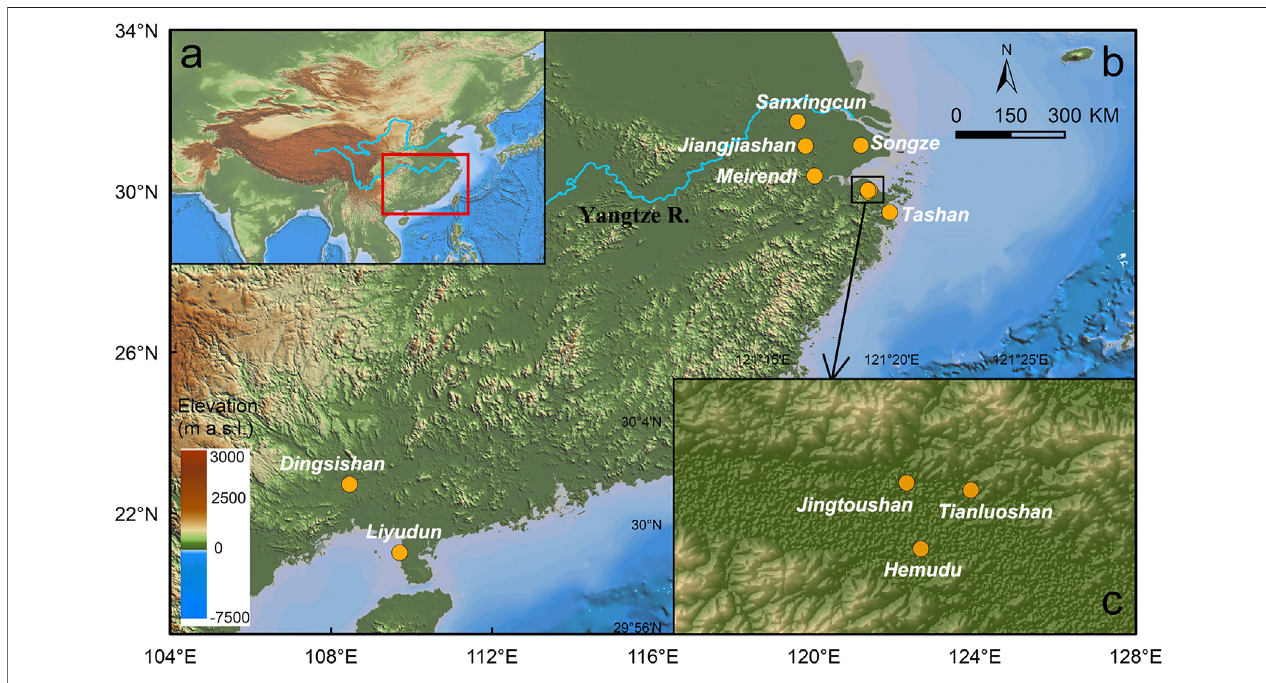
FIGURE 1 | The geographic location of archaeological sites edited by Bing Yi. (A) The study area; (B) Locations of archaeological sites mentioned in the text. (C) Enlarged locations of archaeological sites in the Ningshao Plain.